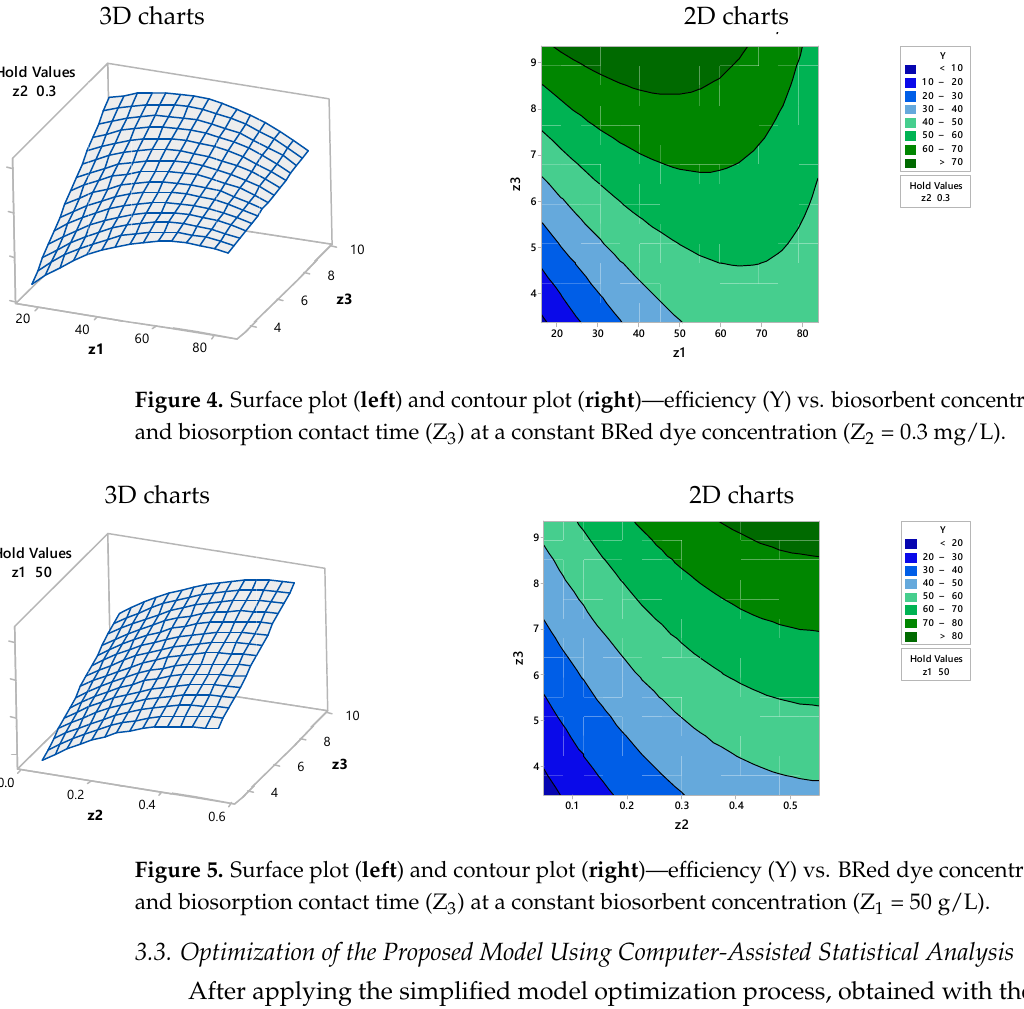
Figure 6. The maximum yield that can be obtained after the optimization of the biosorption process of reactive Brilliant Red HE-3B dye onto a residual S. pastorianus microbial biomass.